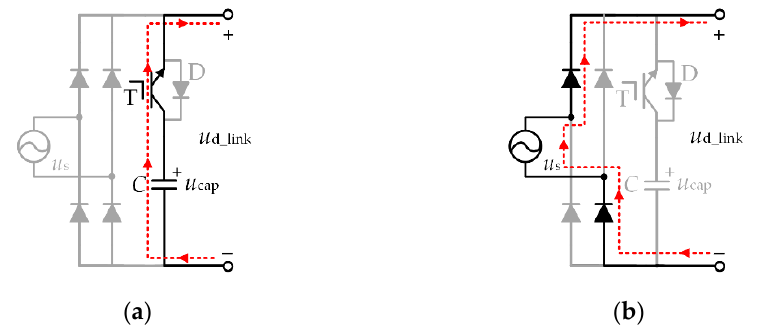
Figure 2. Equivalent circuit of the DC-link ( a ) switch T ON ( b ) switch T OFF.